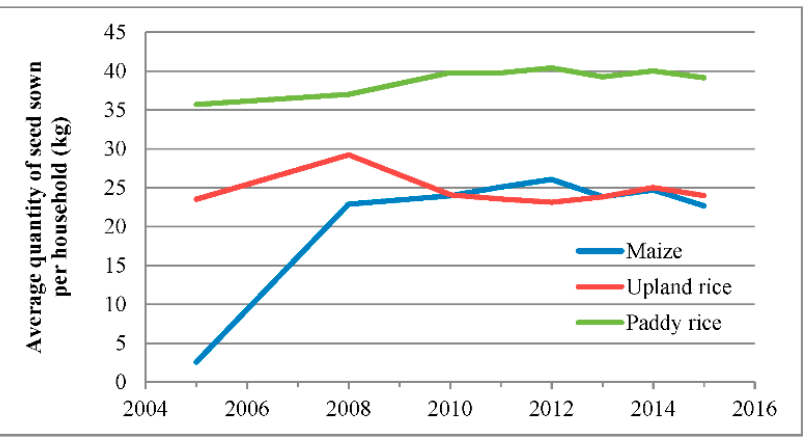
Figure 8. Change in the three main crops from 2005 to 2015.